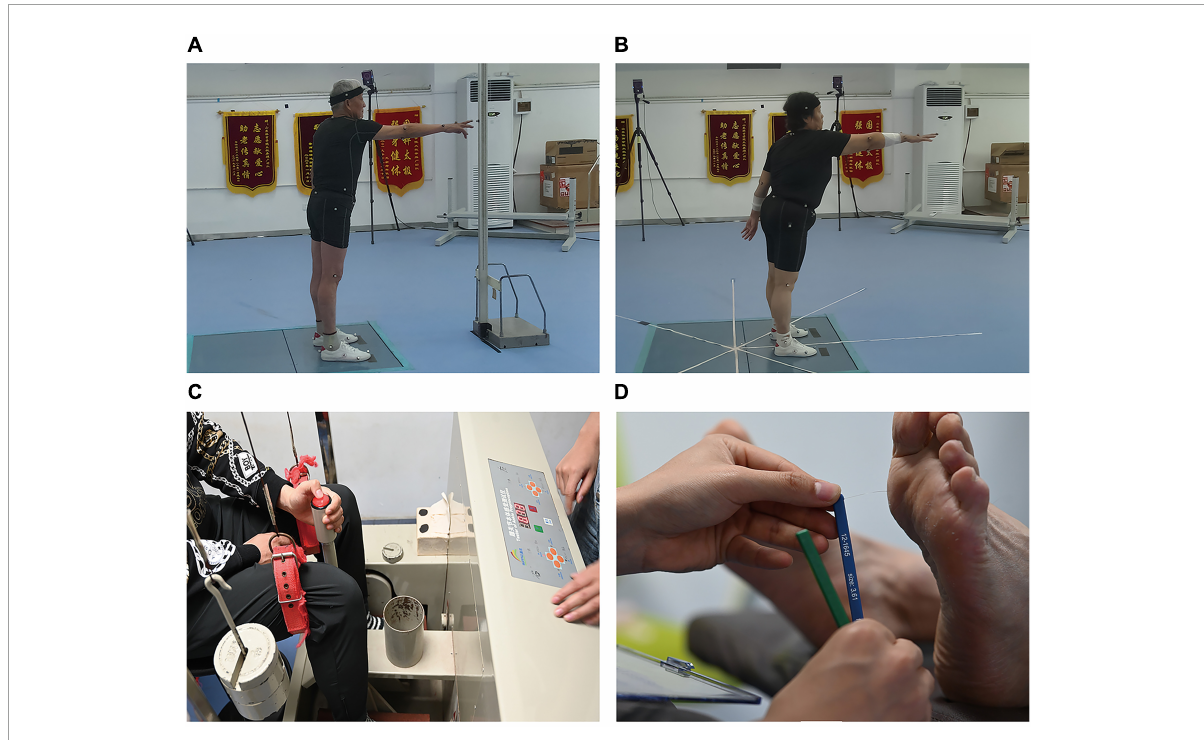
FIGURE1 The illustration about the actual testing protocol. (A) Touch task; (B) blind touch task; (C) proprioception test; (D) tactile sensation